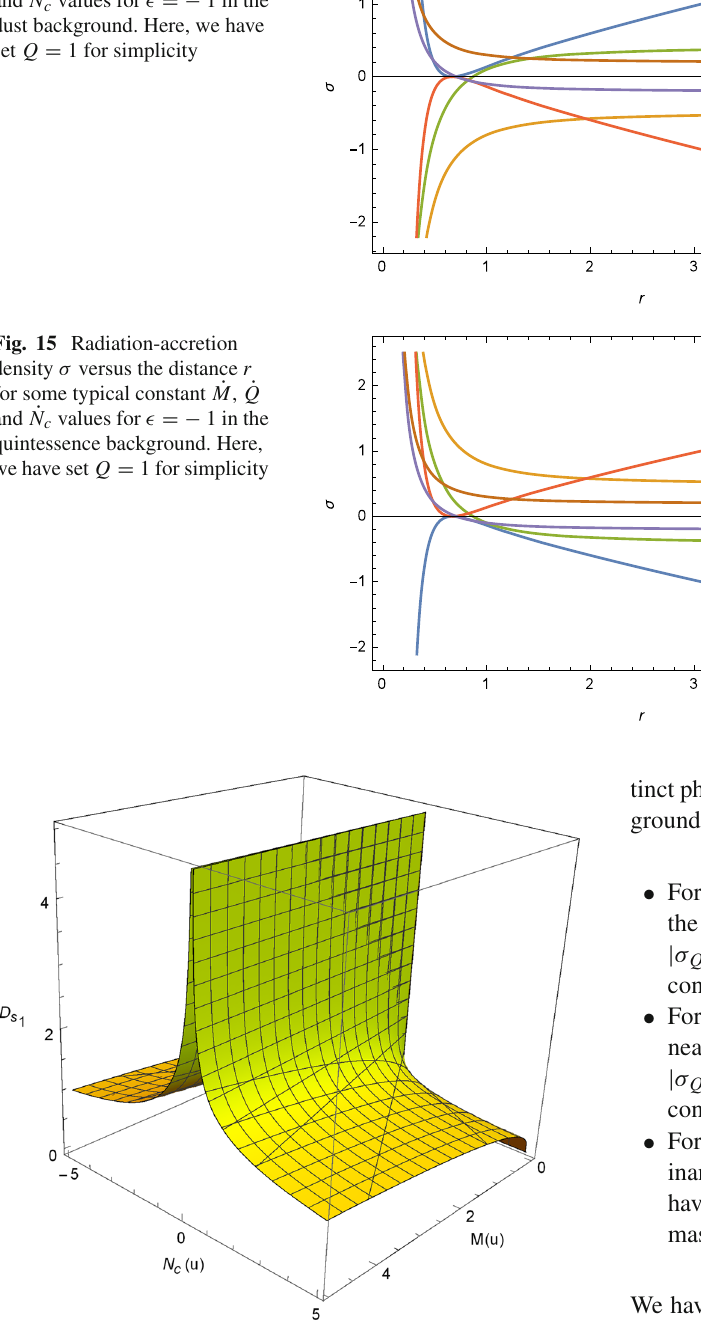
the stationary limit. Regarding the obtained total radiation- accretion density for these solutions, if ˙ N s ( u ) have a same order of magnitude, the following